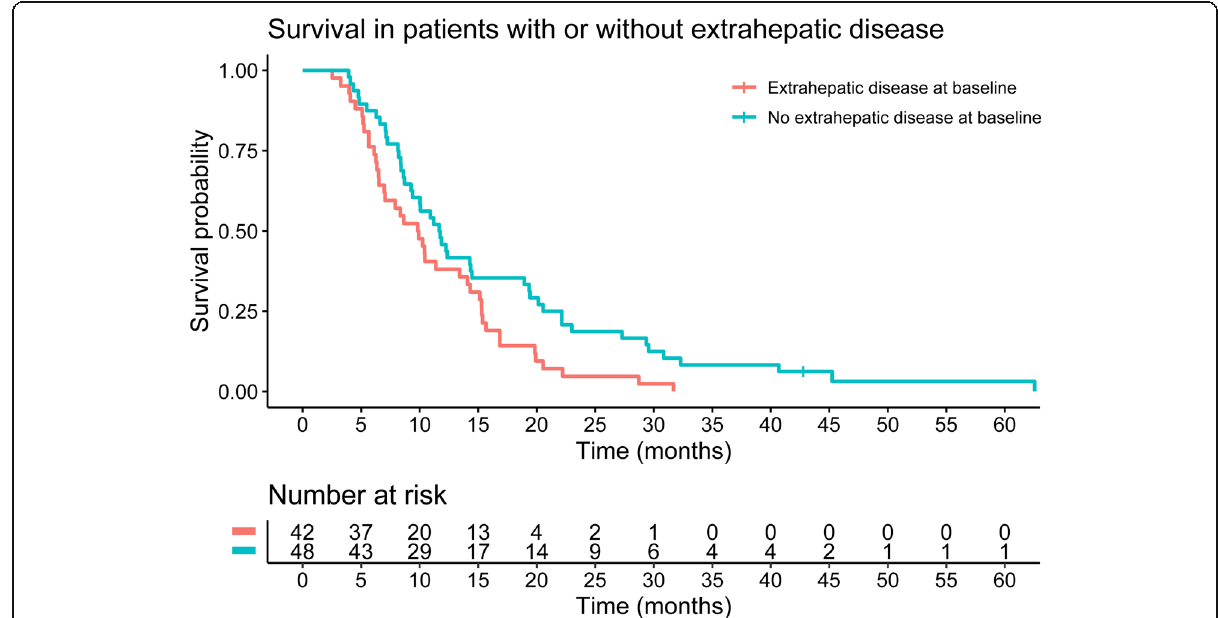
Fig. 4 Kaplan-Meier survival curve stratified for extrahepatic metastases at